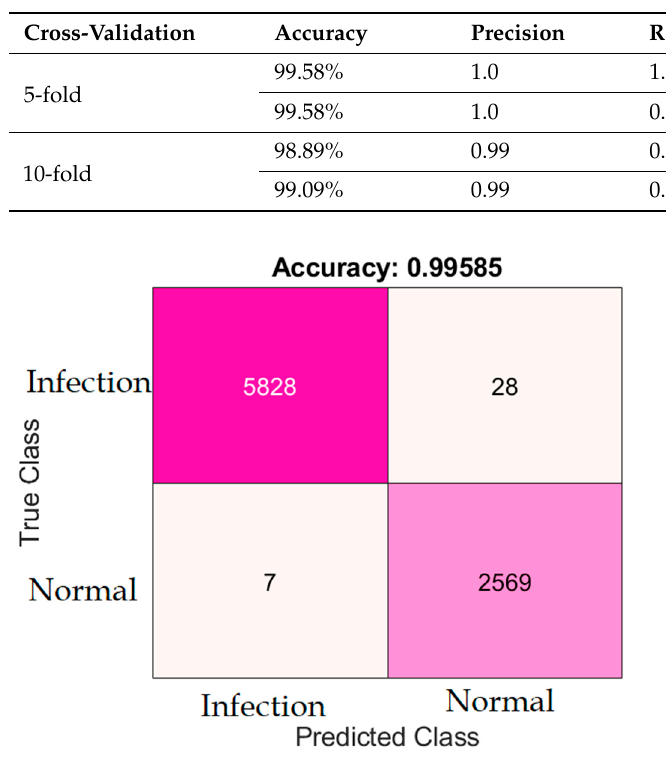
Figure 2. Confusion matrix of the cotton disease classification results. Table 2. Classification results of cotton disease.